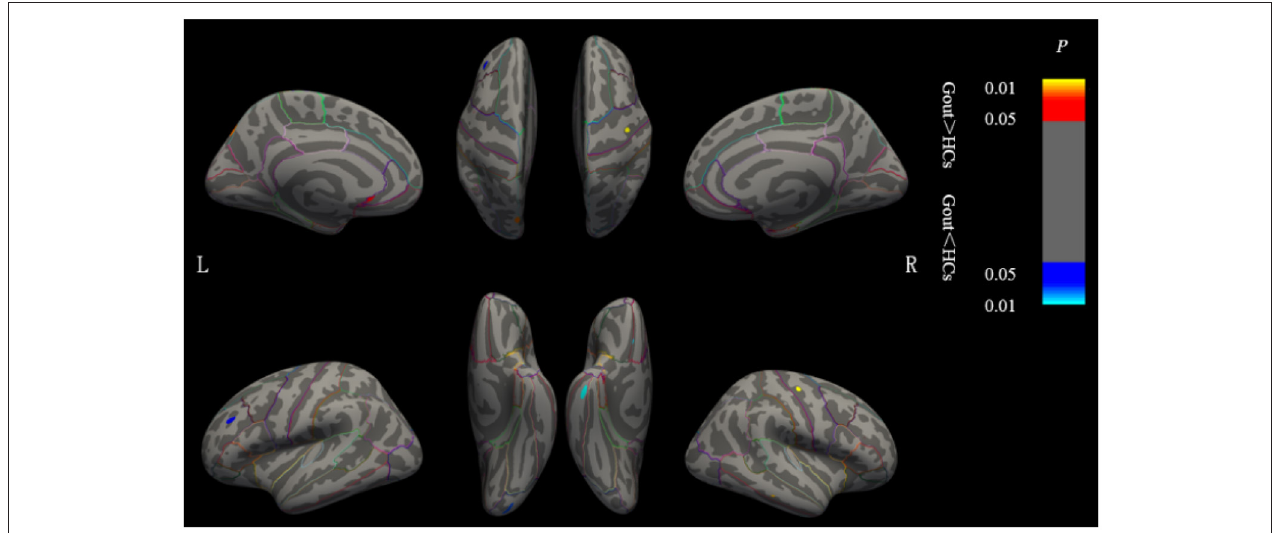
FIGURE 2 | Brain regions where the cortical thickness are different between gout patients and HCs. Cluster of areas with significantly thicker cortex in gout patients, including the left postcentral, left supramarginal, right medial temporal, and right medial orbitofrontal regions. Cluster of areas with significantly thinner cortex in gout patients including the left insula, left superior frontal, right pericalcarine, and right precentral regions (GRF correction, voxel level p < 0.05, cluster level p < 0.01). Cluster with p < 0.01 are shown in the figure. CT, cortical thickness; HCs, healthy controls; L, left; R, right; GRF, Gaussian random field.